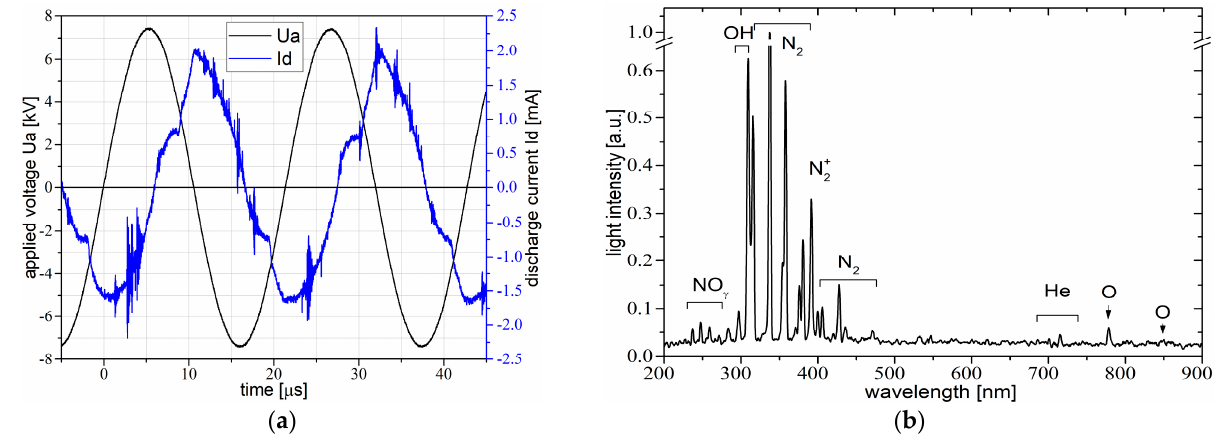
Figure 2. Plasma source electrical ( a ) and optical ( b ) characterization.